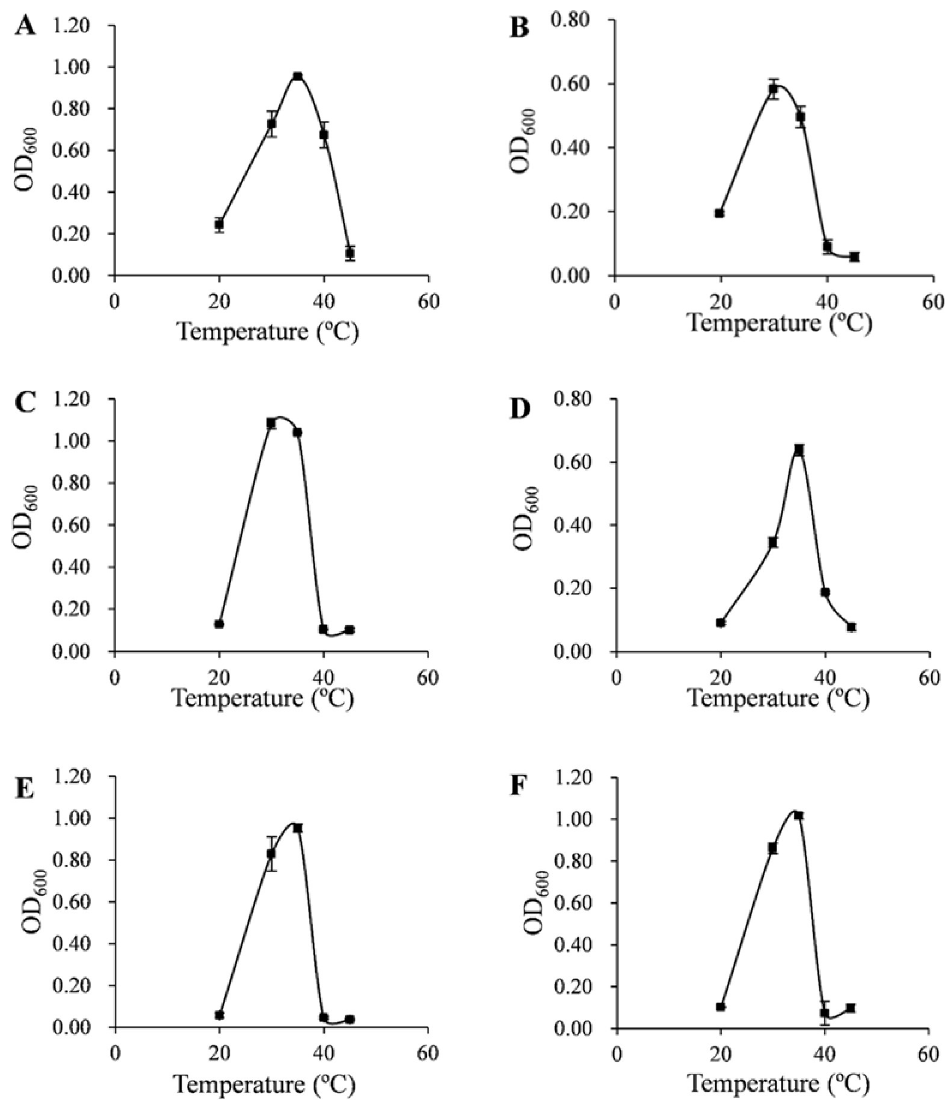
Fig 3. Optimum growth temperatures of isolates ZXY12VA01 (A), ZXY12VA05 (B), ZXY12VA14 (C), ZXY12VA15 (D), ZXY12VA16 (E), ZXY12VA17 (F).